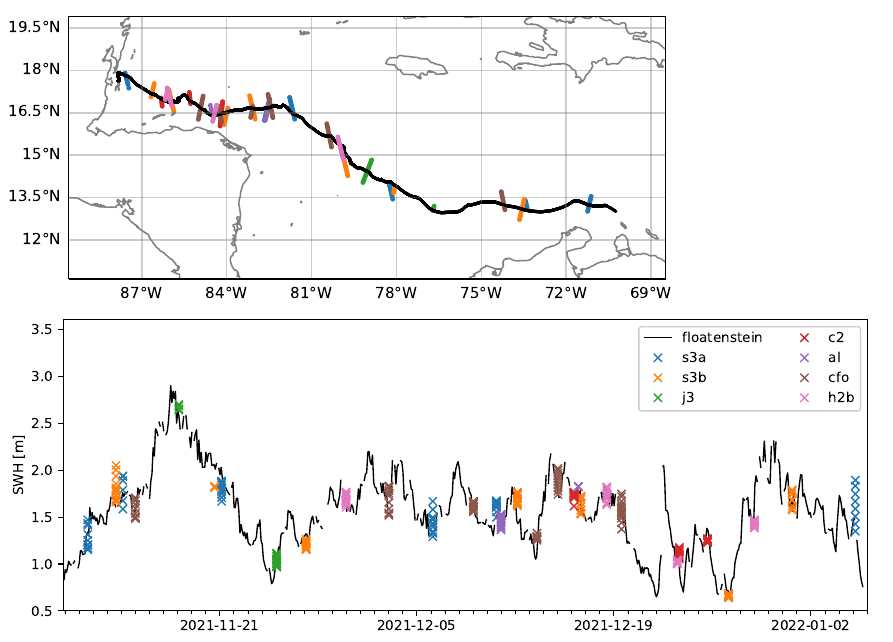
Figure 9. ( Top ): drift pattern of Floatenstein (colored continuous black line) and satellite measurement transects (colored points) over which wave characteristics are measured by the satellites. ( Bottom ): comparison of the Significant Wave Height (SWH) (i) reported by Floatenstein (continuous black line) and (ii) from satellite measurements on the corresponding measurement